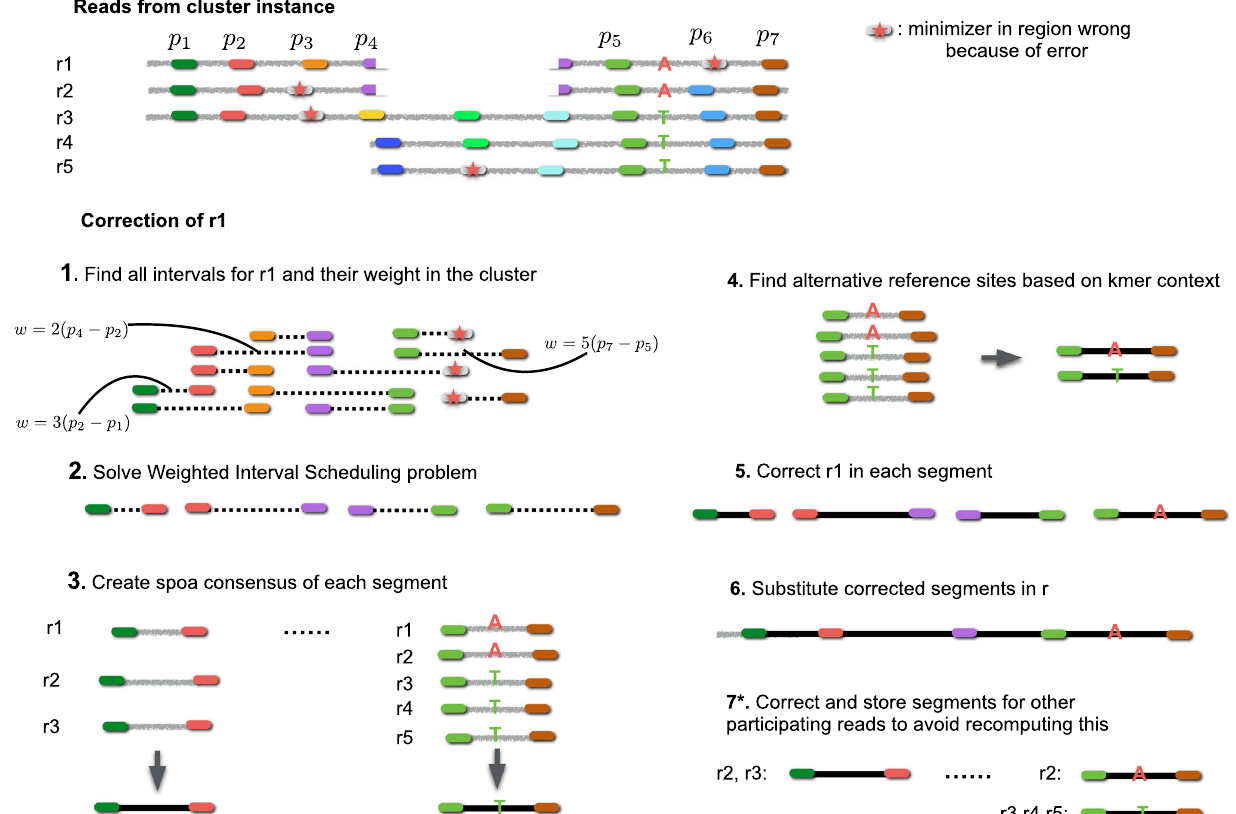
r 1), all the anchor minimizer